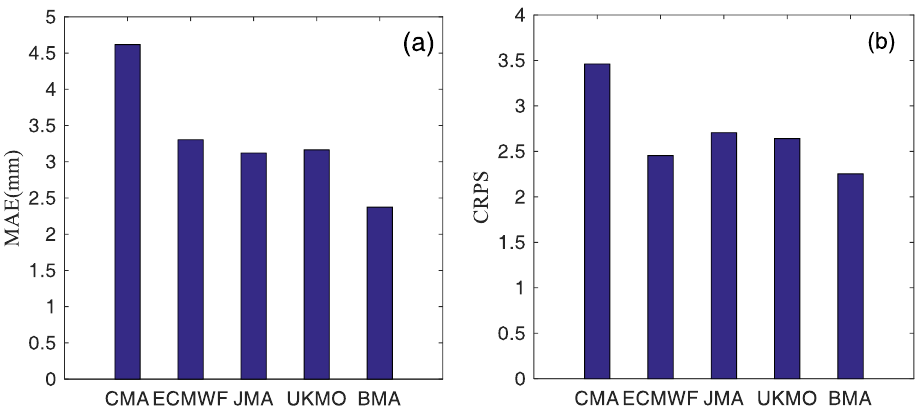
Figure 8. ( a ) MAE and ( b ) continuous ranked probability score (CRPS) from the four centers and BMA during 21 July to 31 August 2018.